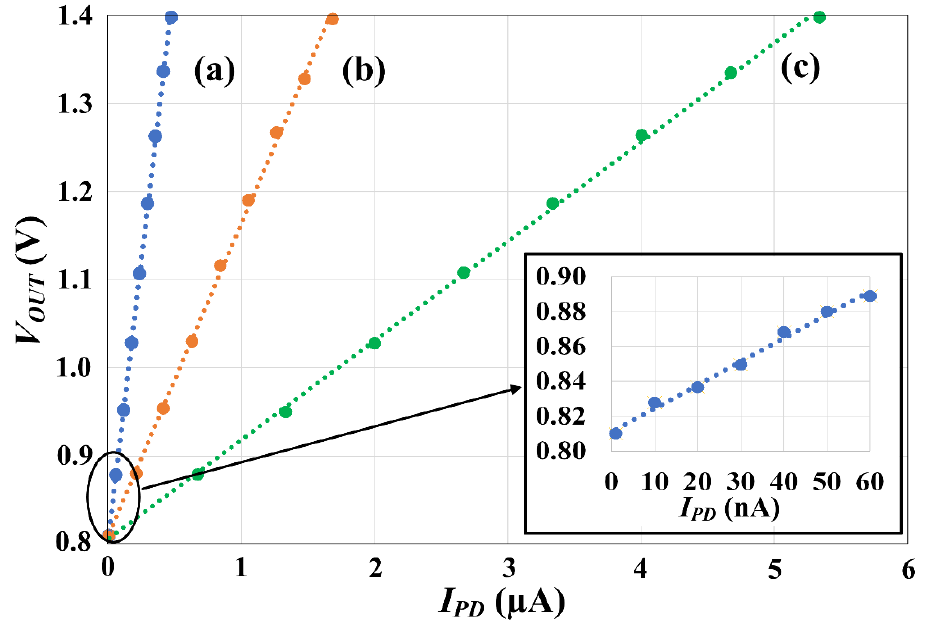
Figure 5. DC sweep analysis (and their linear fittings) performed with the CMOS integrated TIA for different values of the digital control voltages V 1 , V 2 , and V 3 by fixing the analog voltage V AN = 1.8 V: plot (a) V 1 = V 2 = 0 and V 3 = 1.8 V; plot (b) V 1 = V 3 = 0 V and V 2 = 1.8 V; plot (c) V 2 = V 3 = 0 V and V 1 = 1.8 V. The inset shows a magnification of V OUT setting the transimpedance gain equal to 123 dbΩ for the input current I PD varying from 2 nA to 60 nA.